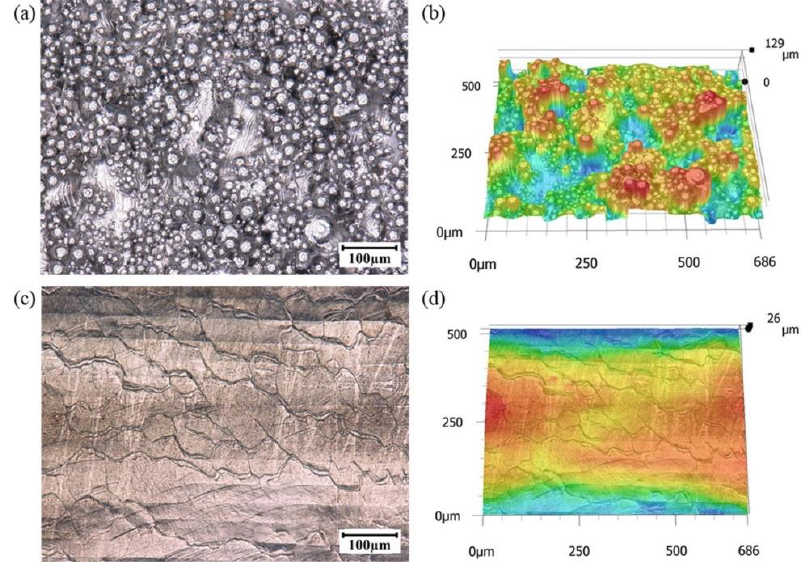
Figure 15. ( a , b ) Optical image and color map of α + β Ti -alloy before polishing, and ( c , d ) optical image and color map of α + β Ti -alloy after polishing [83]; with permission from Elsevier.